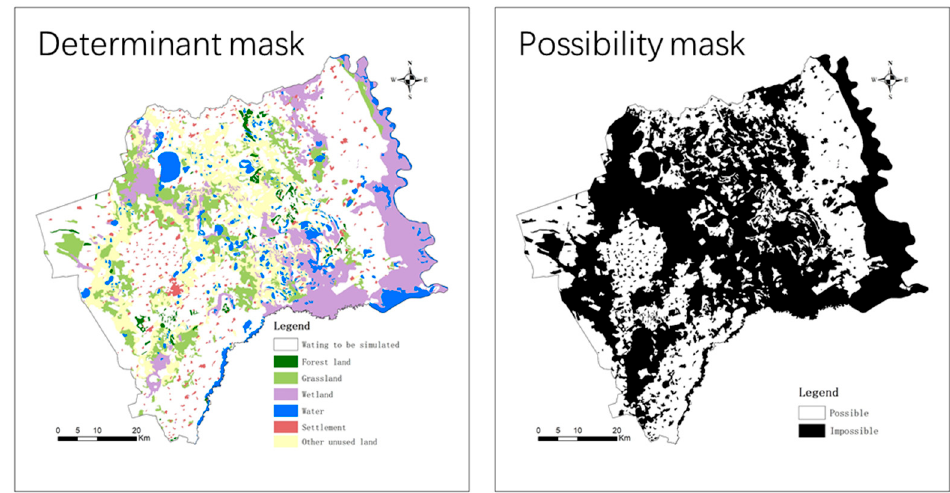
Figure 8. Determinant mask and Possibility mask.